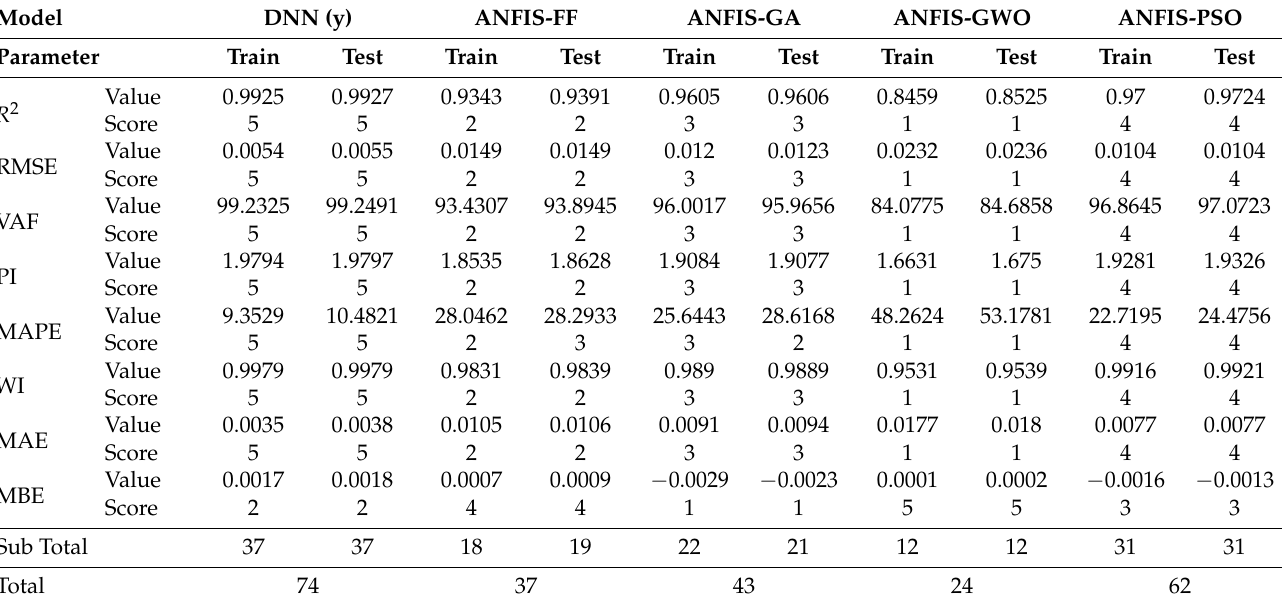
Table 2. Statistical parameter of all the models in longitudinal ( y )